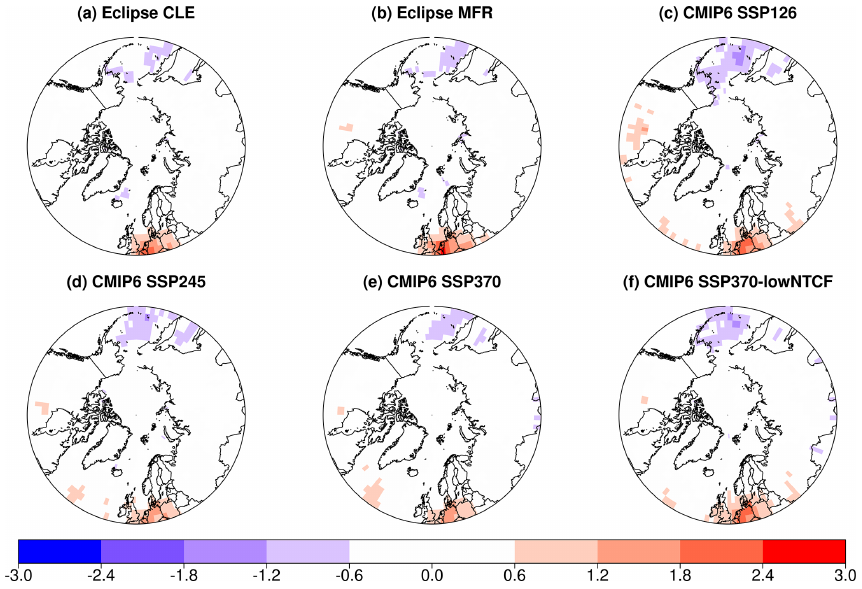
Figure 9. Spatial distribution of the statistically significant annual mean Arctic RF ARI (Wm − 2 ) changes between the 1990–2010 mean and the 2030–2050 mean as calculated by the GISS-E2.1 ensemble.